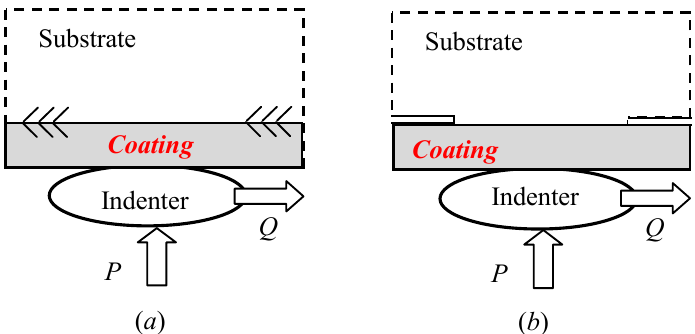
Figure 11. Contact systems with a single coating layer: ( a ) Perfectly bonded interface; ( b ) Rested on substrate (receding contact).